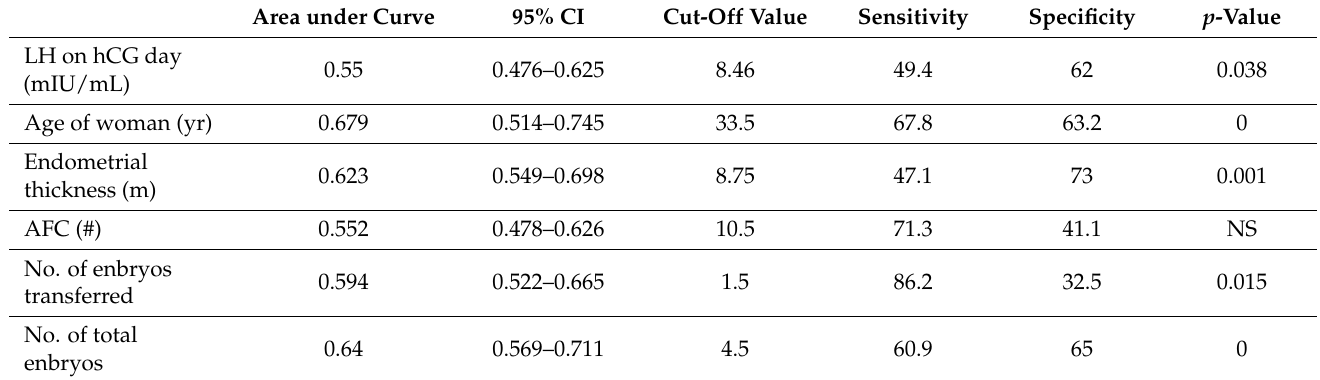
Table 4. Area under curve of ROC analysis and specific cut-off values for prediction of live birth.